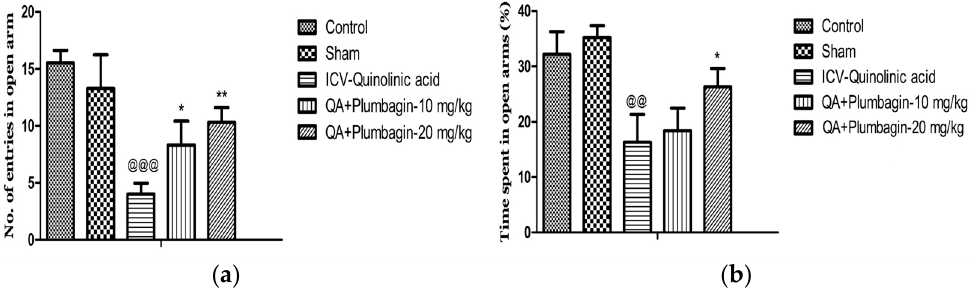
Figure 4. ( a ) Effect of plumbagin on QA-induced decrease no. of entries in open arms in EPM; ( b ) Effect of plumbagin on QA-induced diminution in percent time consumed in exposed arms during EPM. Data represent mean ± SEM ( n = 6). @@ p < 0.01 as compared to control group; @@@ p < 0.01 as compared to control group; * p < 0.05 and ** p < 0.01 as compared to QA-induced group.